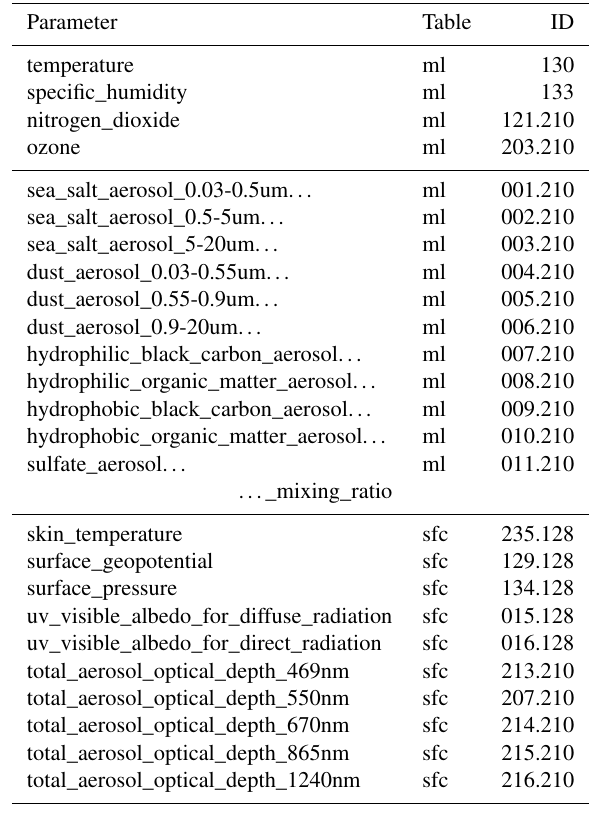
Table B1. List of acquired CAMS RA parameters for this study. The table keyword specifies if the parameter is acquired for the surface (sfc) or model level vertical column